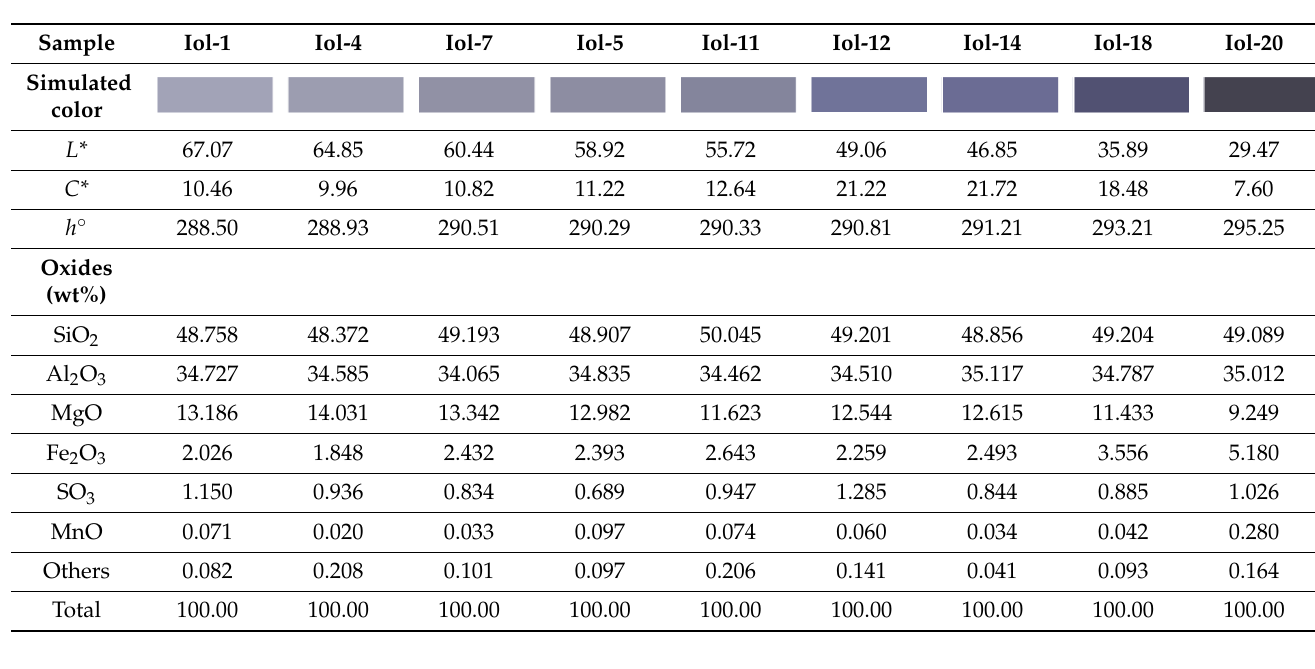
Figure 4. The crystal structure of iolite (from Christian Bertoldi [33]). Table 2. The ED-XRF data of